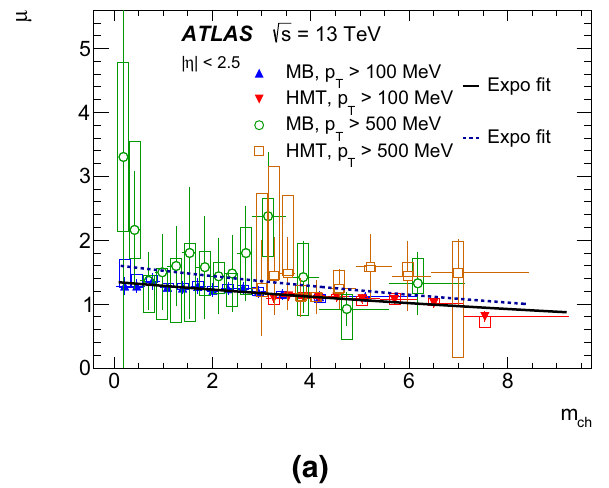
√ s = 13 TeV. The error bars and boxes represent the statistical and at systematic contributions, respectively. The black solid (blue dashed) curve represents the exponential fit of the dependence of parameter μ ( ν ) on m ch for tracks with p T > 100 MeV ( p T > 500 MeV)